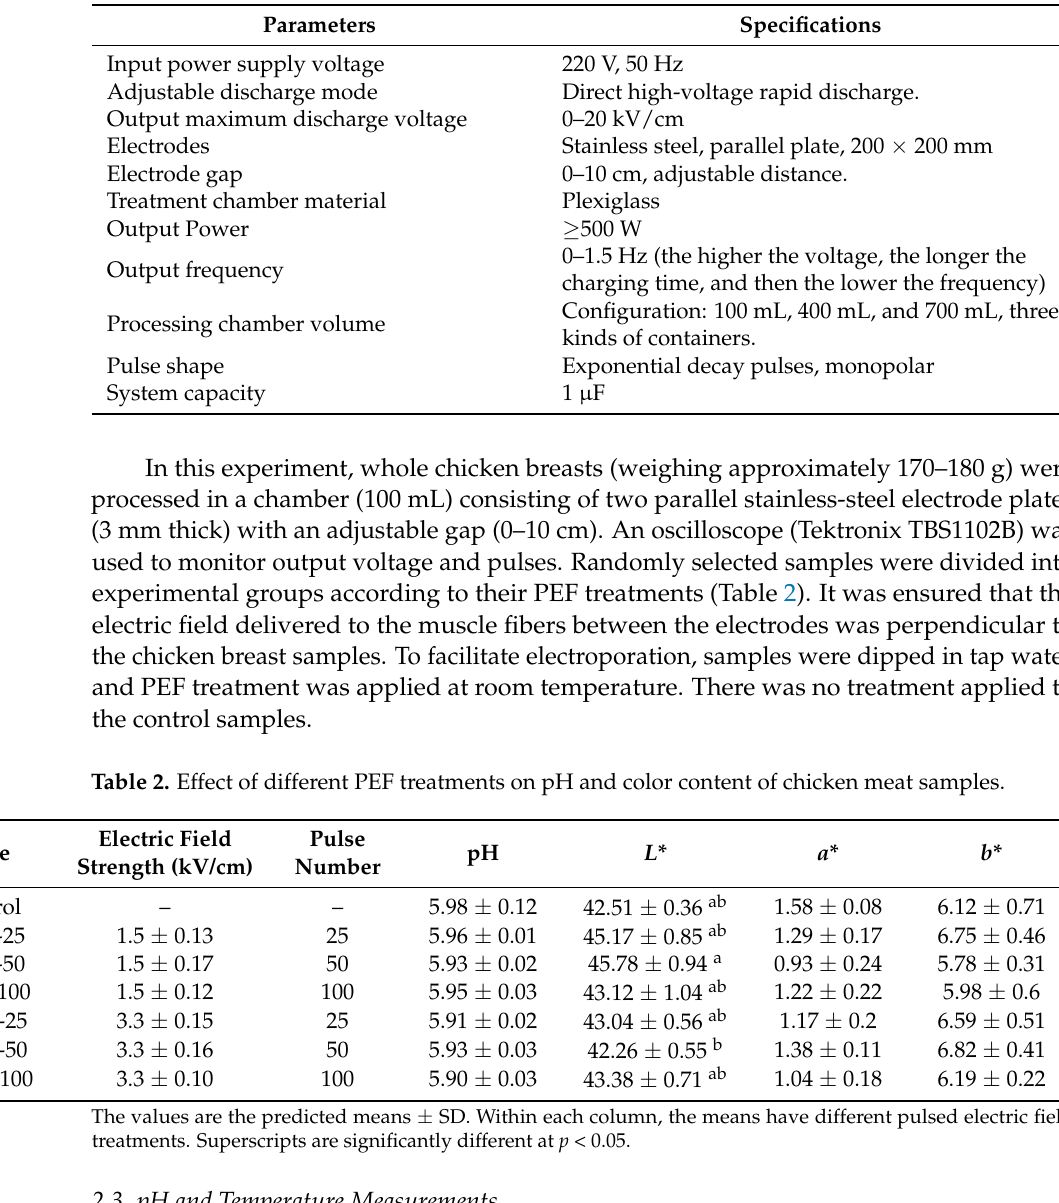
Table 1. Technical data of the PEF-EX-1900 batch system (Xi-nan Technology Company, China).